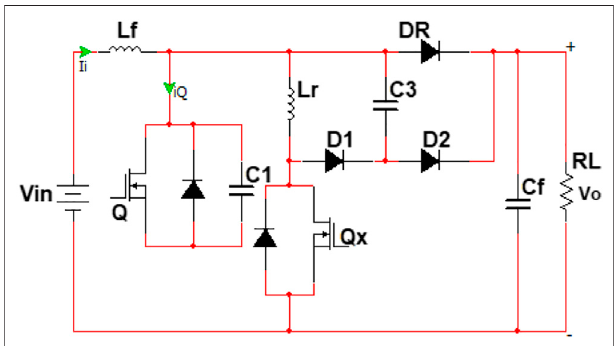
FIGURE 7 | Topology of improved ZVT soft-switching Boost circuit.